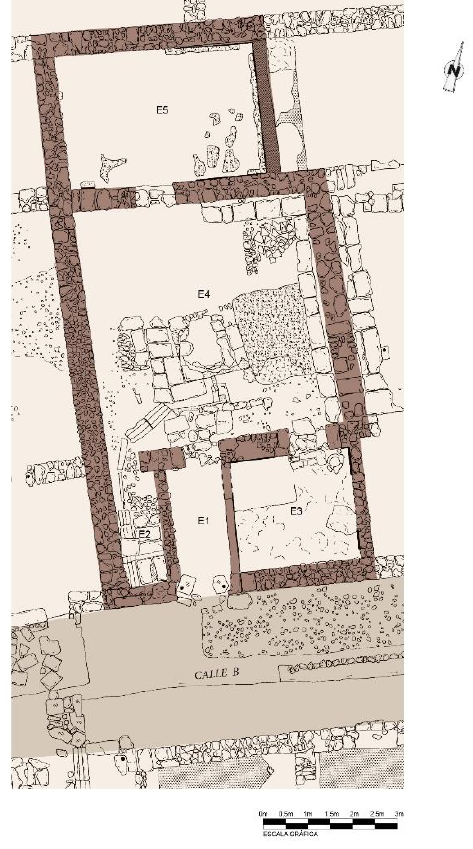
Figure 9. Variant 1. House 113. Plan and room distribution.